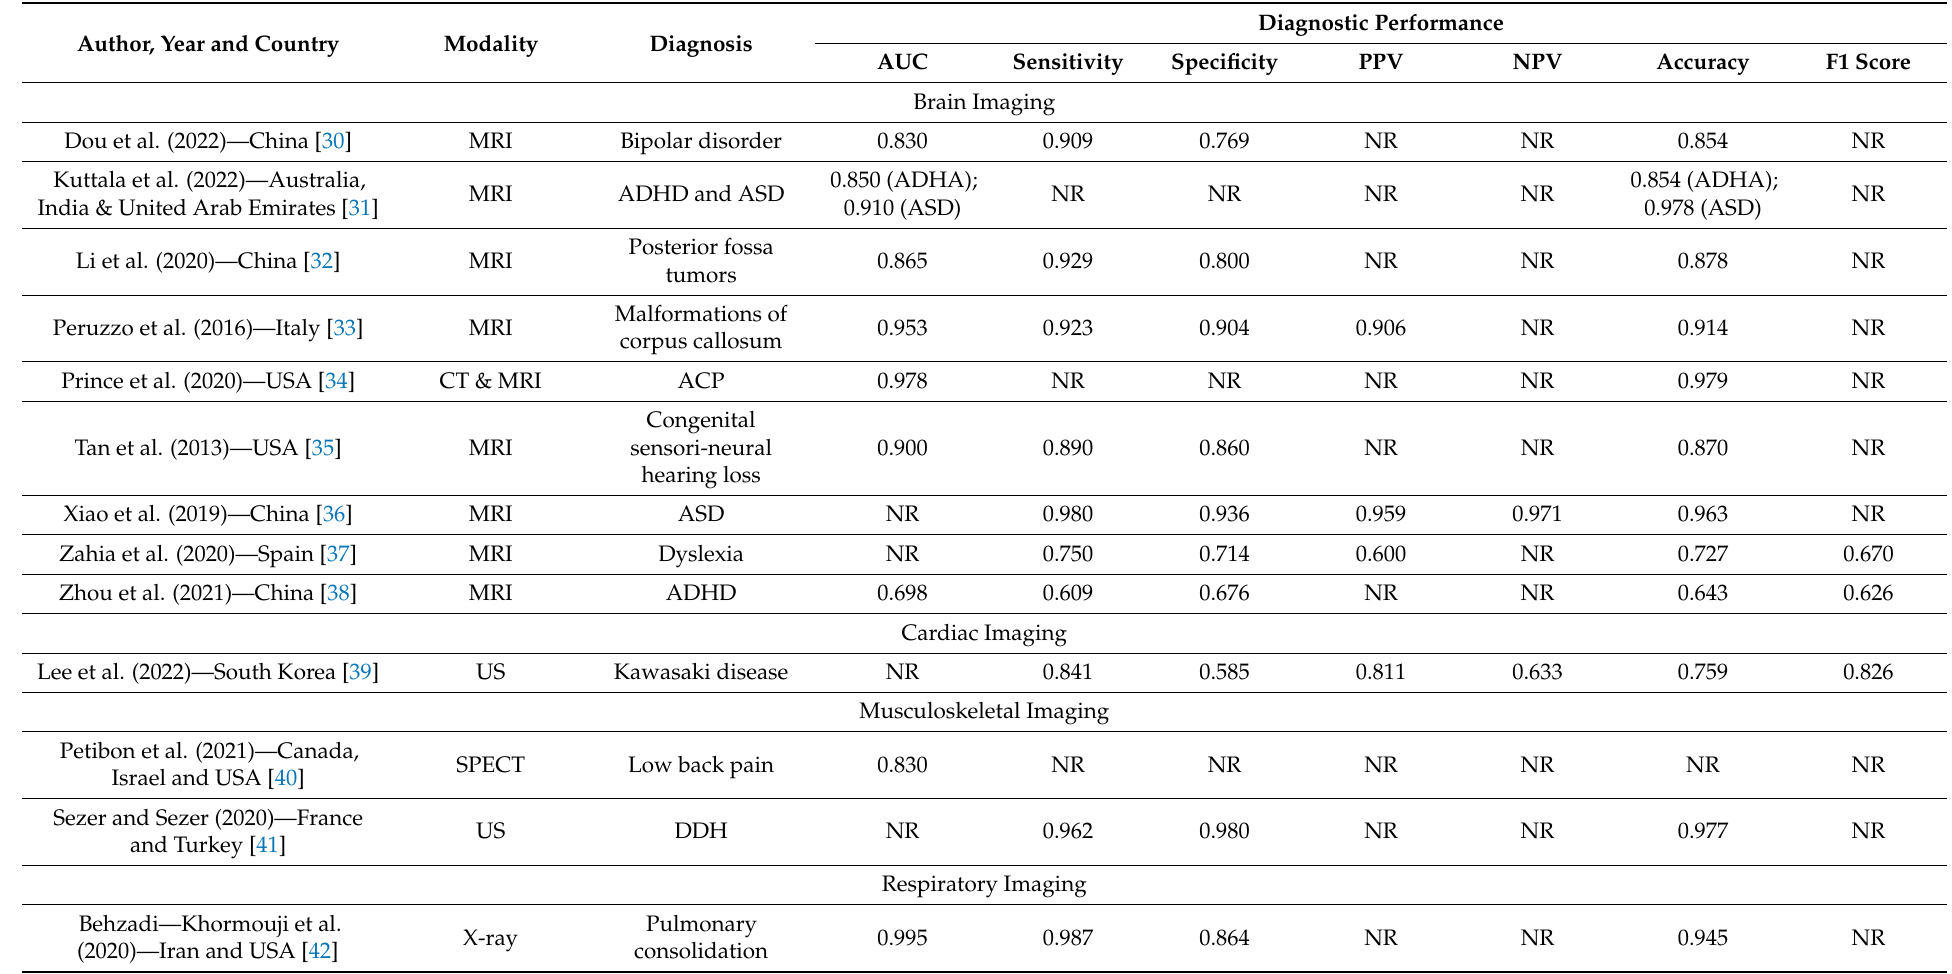
Table 1. Artificial intelligence-based computer-aided detection and diagnosis application areas in pediatric radiology and their diagnostic